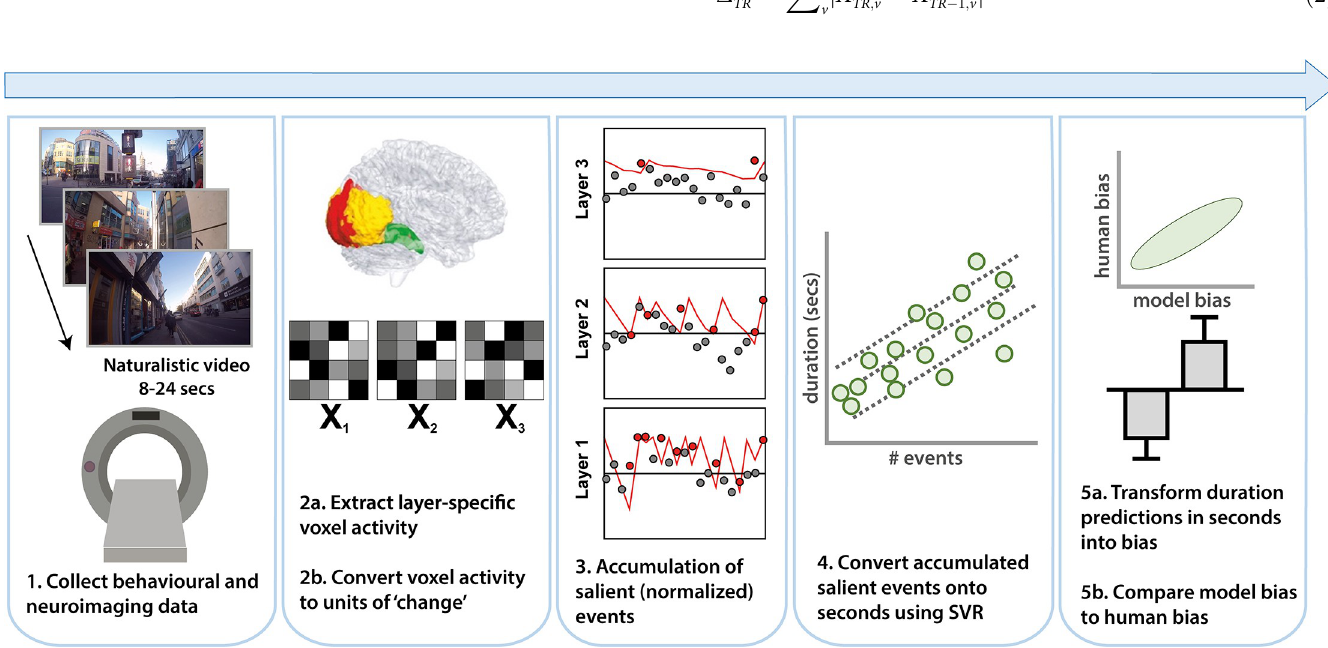
Fig 4. Schematic of modelling analysis pipeline. (1) Following data collection, (2a) voxel-wise BOLD amplitude was extracted and (2b) TR-by-TR (i.e. time point-by- time point, TR = repetition time) changes (Euclidean distance or signed difference) computed. The example given here is for the visual hierarchy, where each shaded matrix X k illustratively represents voxel-wise BOLD amplitudes (shaded squares) at each slice. The same process was conducted for the auditory and somatosensory hierarchies (see Fig 3 and S1 Table for different hierarchies). (3) Total change in the layer/ROI at each TR was compared to a dynamic attention threshold (red line) that categorized events as salient (red dots) or not (grey dots). The black line represents 0. An event was classified as salient if it took an equal or higher value than the threshold. (4) Accumulated salient events were regressed onto seconds, (5a) predictions from the model were converted into normalized bias (5b) and compared across condition and with human